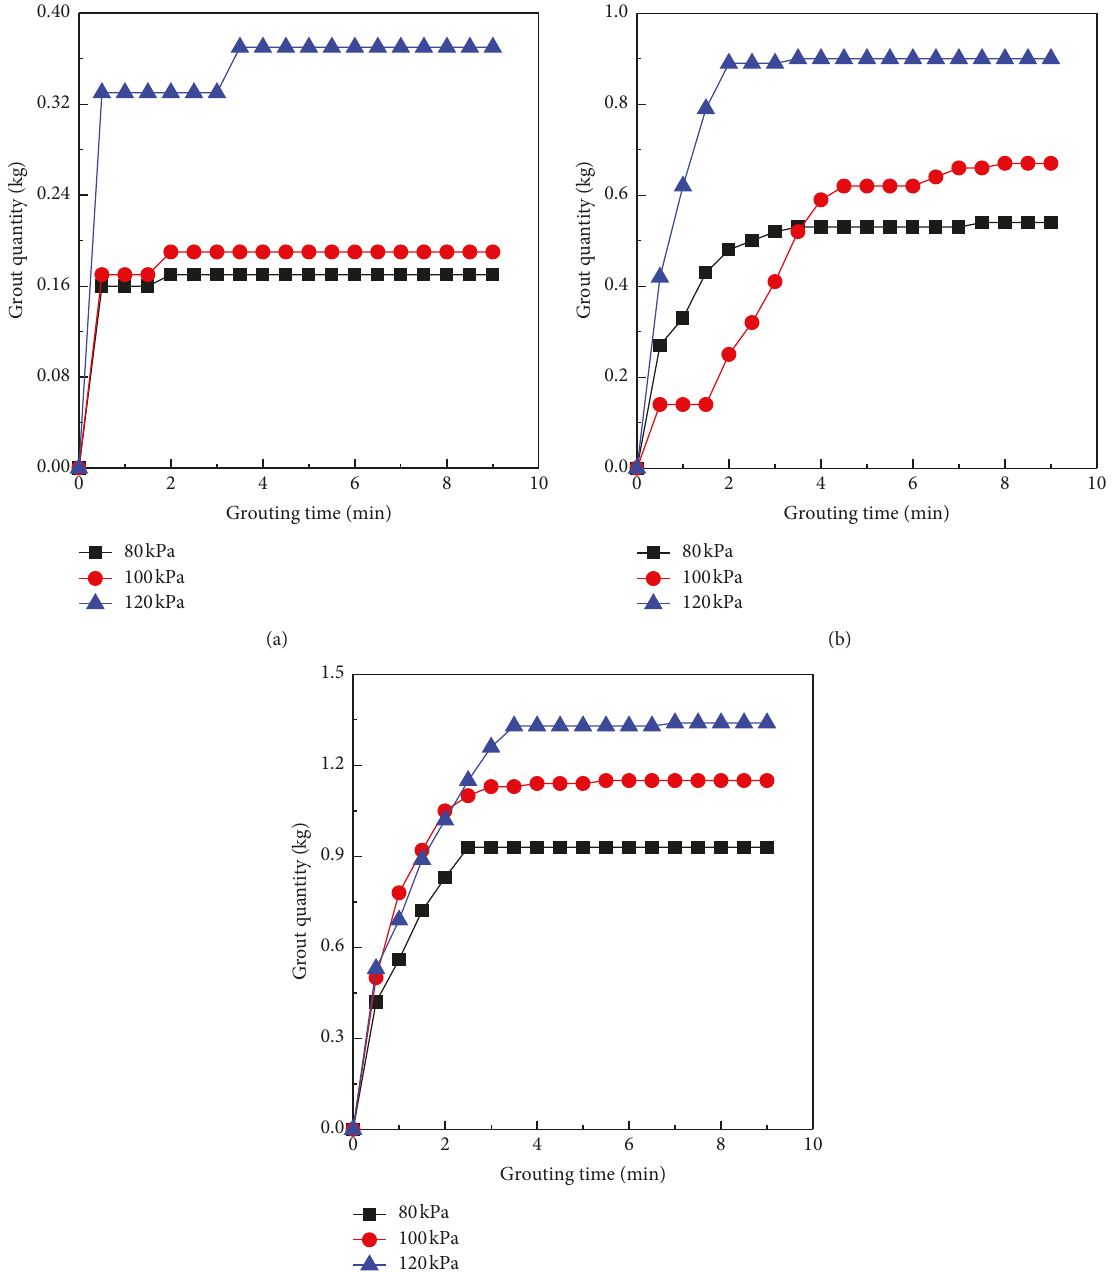
Figure 7: Grout quantity vs. time under different injection pressures and ( w / c ) ratios. ( w / c ) ratios of (a) 1.0, (b) 1.5, and (c)